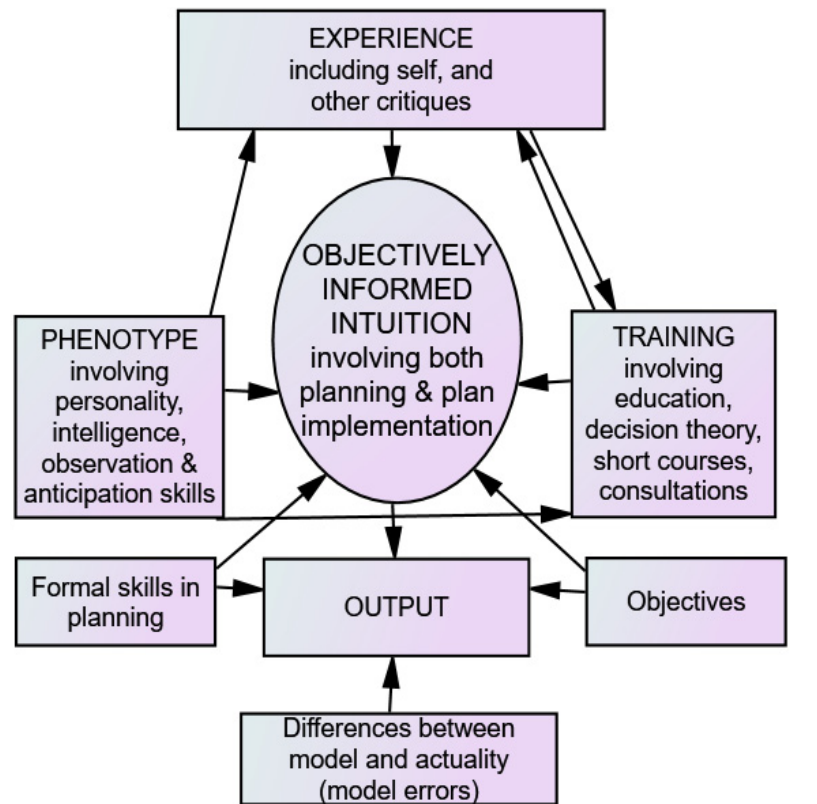
Figure 1. An outline of a model explaining the contributors to ‘objectively informed intuition’ decision making and the resultant output.